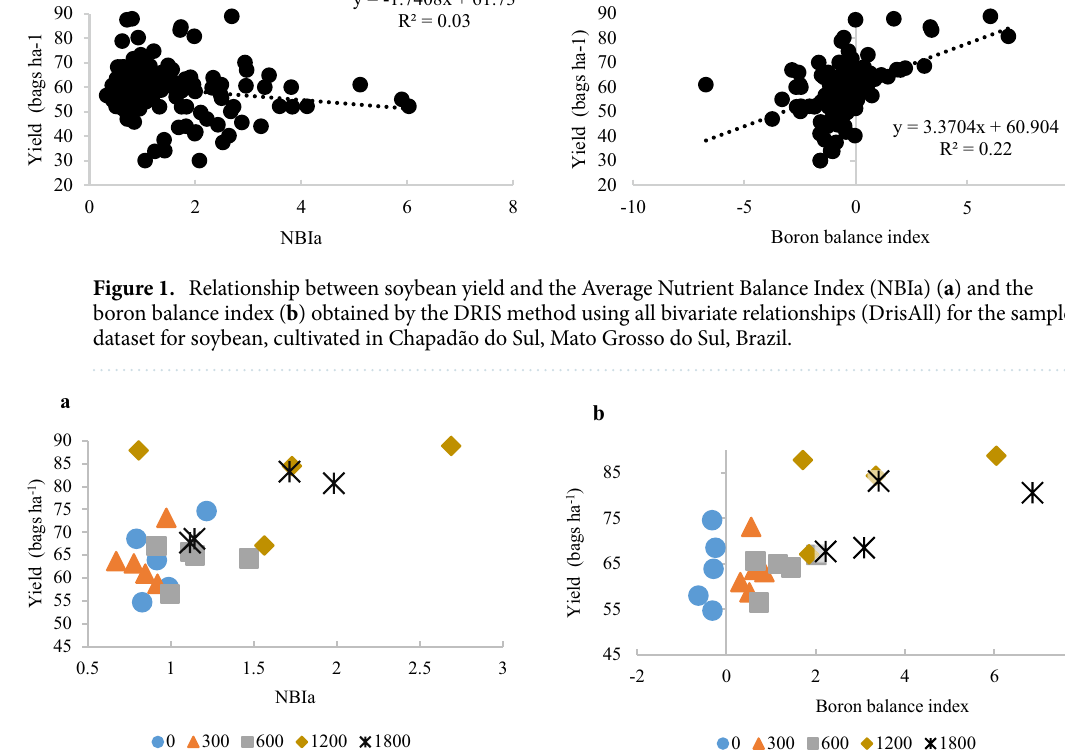
y = -1.7408x + 61.73 R² = 0.03